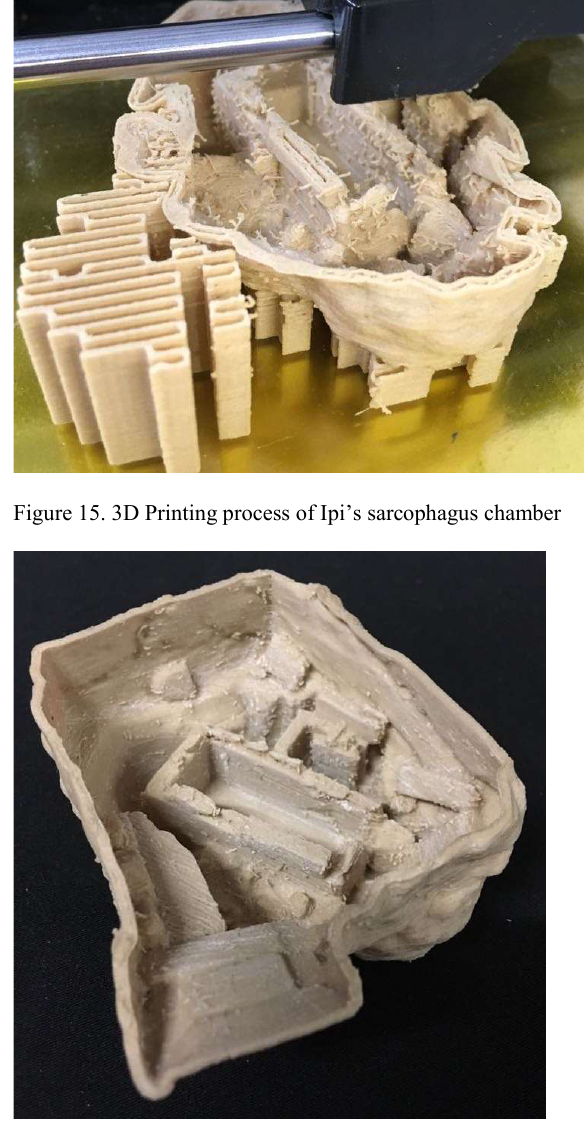
Figure 16. Indoor detail of sarcophagus chamber. 3D